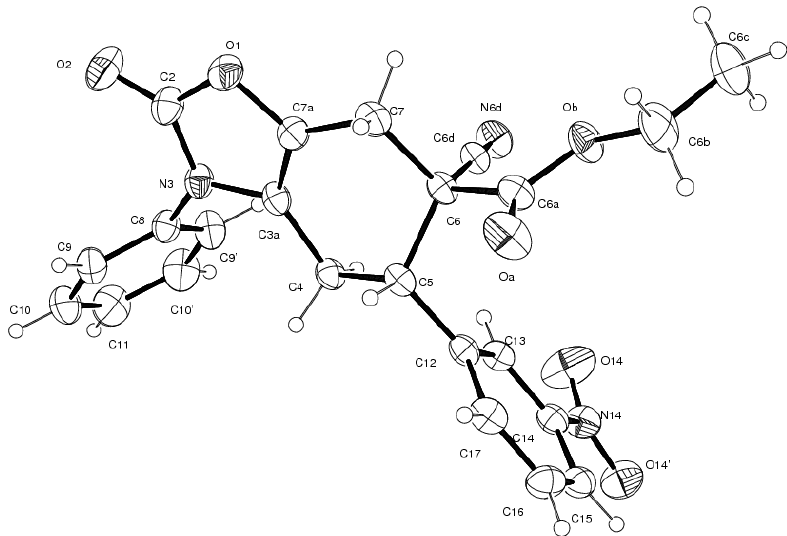
Figure 2. Molecular structure of 7e with thermal ellipsoids at the 30% probability